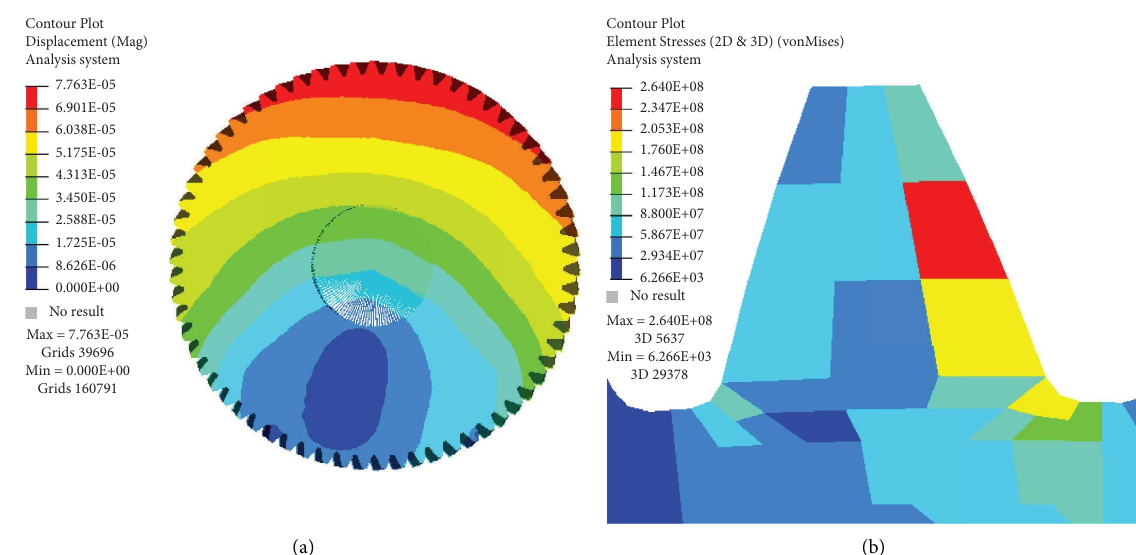
Figure 13: Statics analysis of a multiobjective optimization model. (a) Schematic of gear displacement cloud. (b) Schematic of gear Von Mises stress cloud.